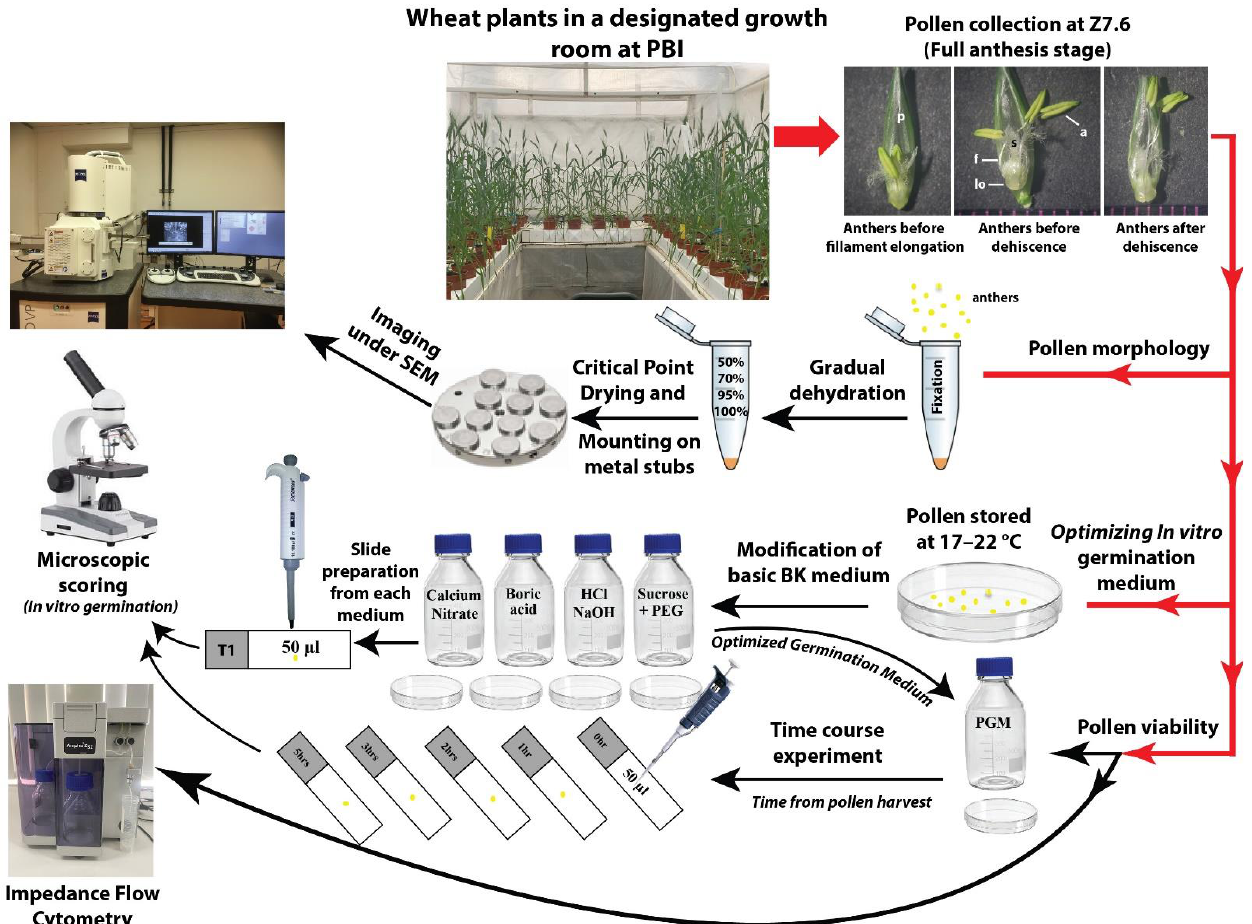
Figure 1. Schematic presentation of overall methodology used in this study. Abbreviations: a, anther; f, filament; lo, lodicule; p, palea; PGM, pollen germination medium; s, stigma.